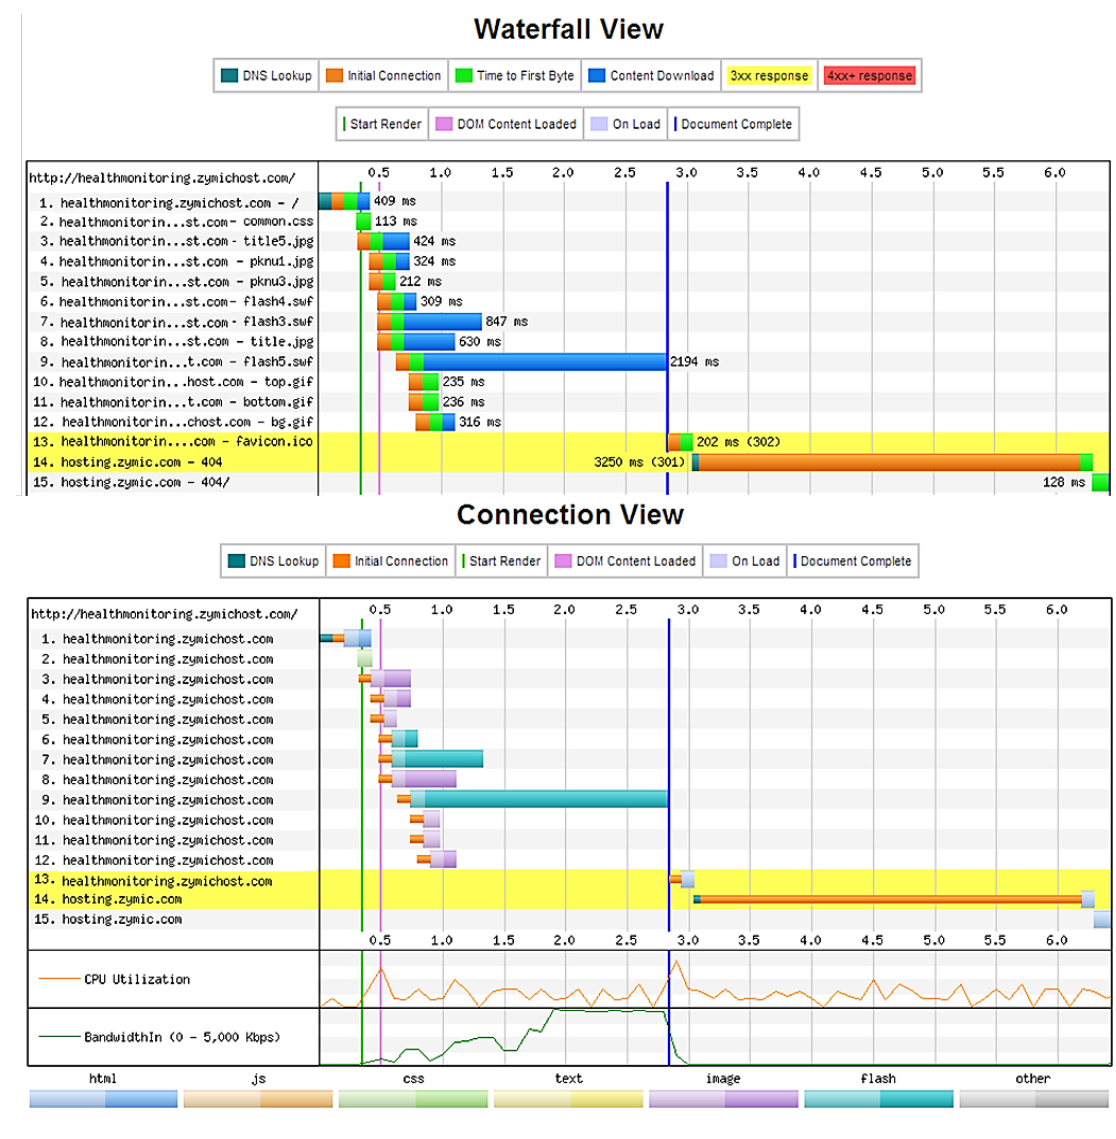
Figure 18. Evaluation in the waterfall and connection